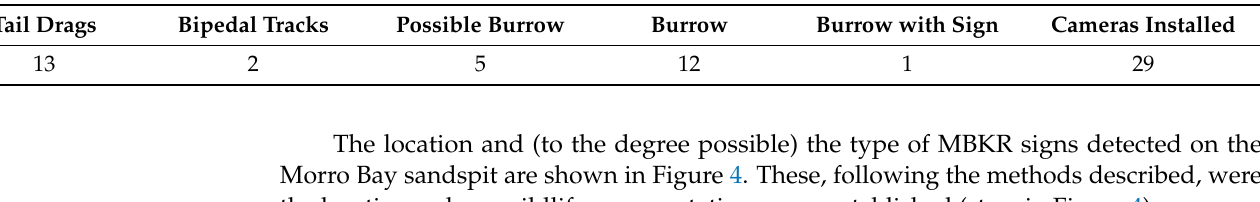
Table 2. Summary of possible MBKR signs found at the Morro Bay Sandspit in San Luis Obispo County, CA. Values represent total signs across all transects